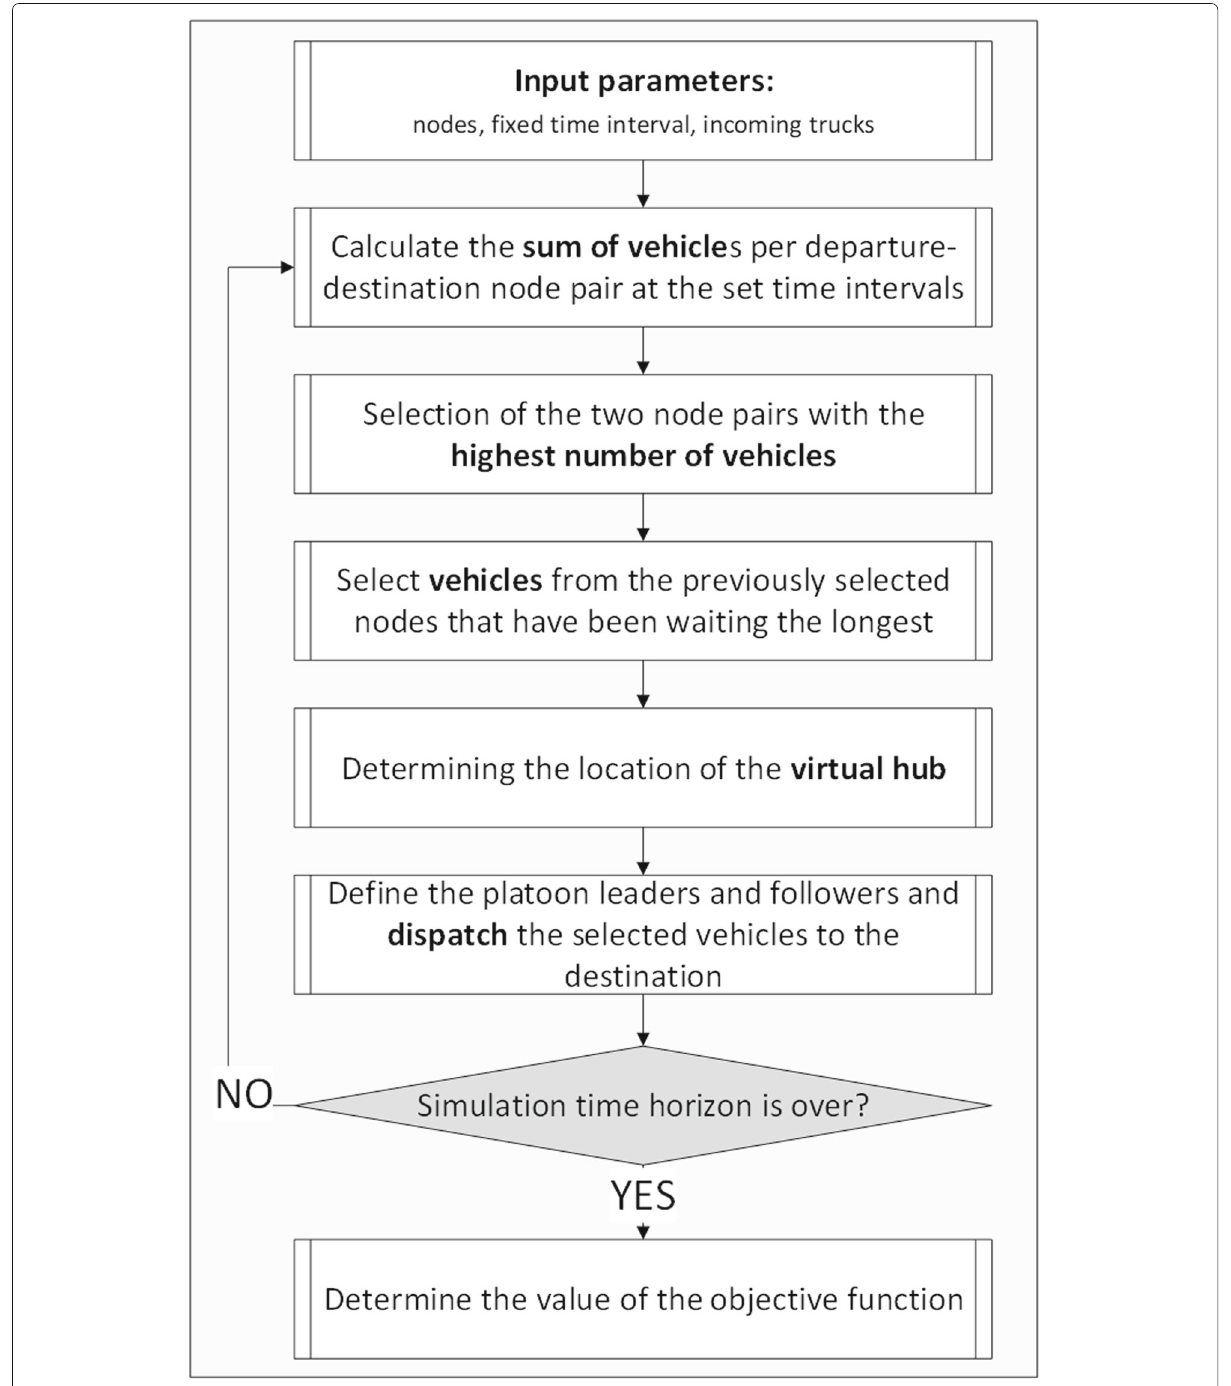
Fig. 3 Flowchart of a first algorithm - Heuristic